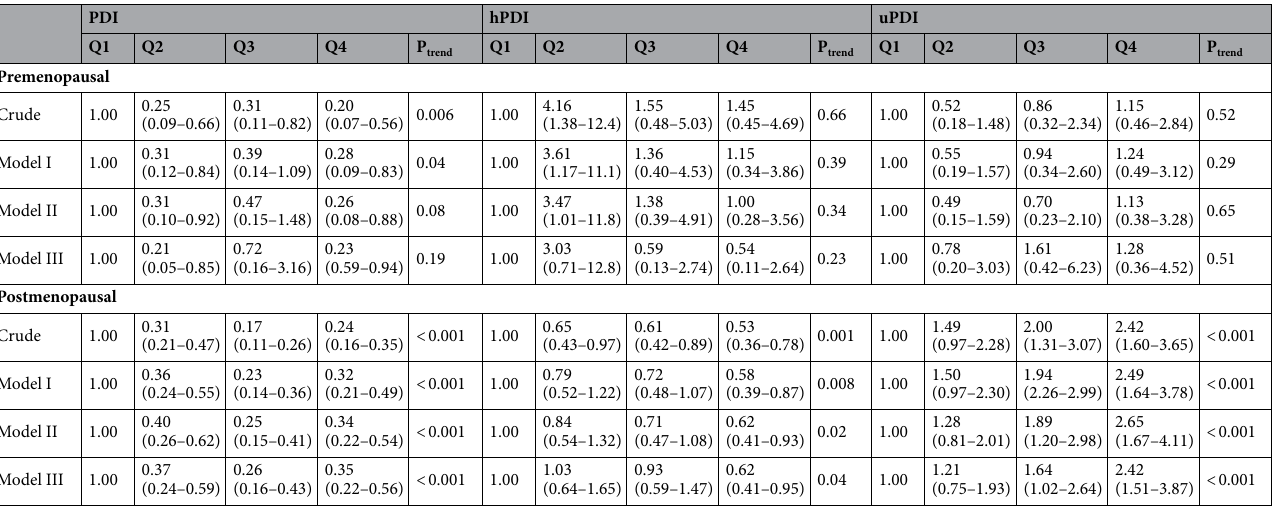
Table 5. Crude and multivariable-adjusted ORs and 95% CIs for breast cancer across quartiles of PDI, hPDI, and uPDI scores stratified based on menopausal status. Data are presented as OR (95% CI). Model I: Adjusted for age and energy intake. Model II: Additionally, adjusted for education, social economic status, residential area, supplement use, family history of breast cancer, disease history, physical activity, marital status, smoking status, alcohol consumption, history of breast-feeding. Model III: Further adjustment for